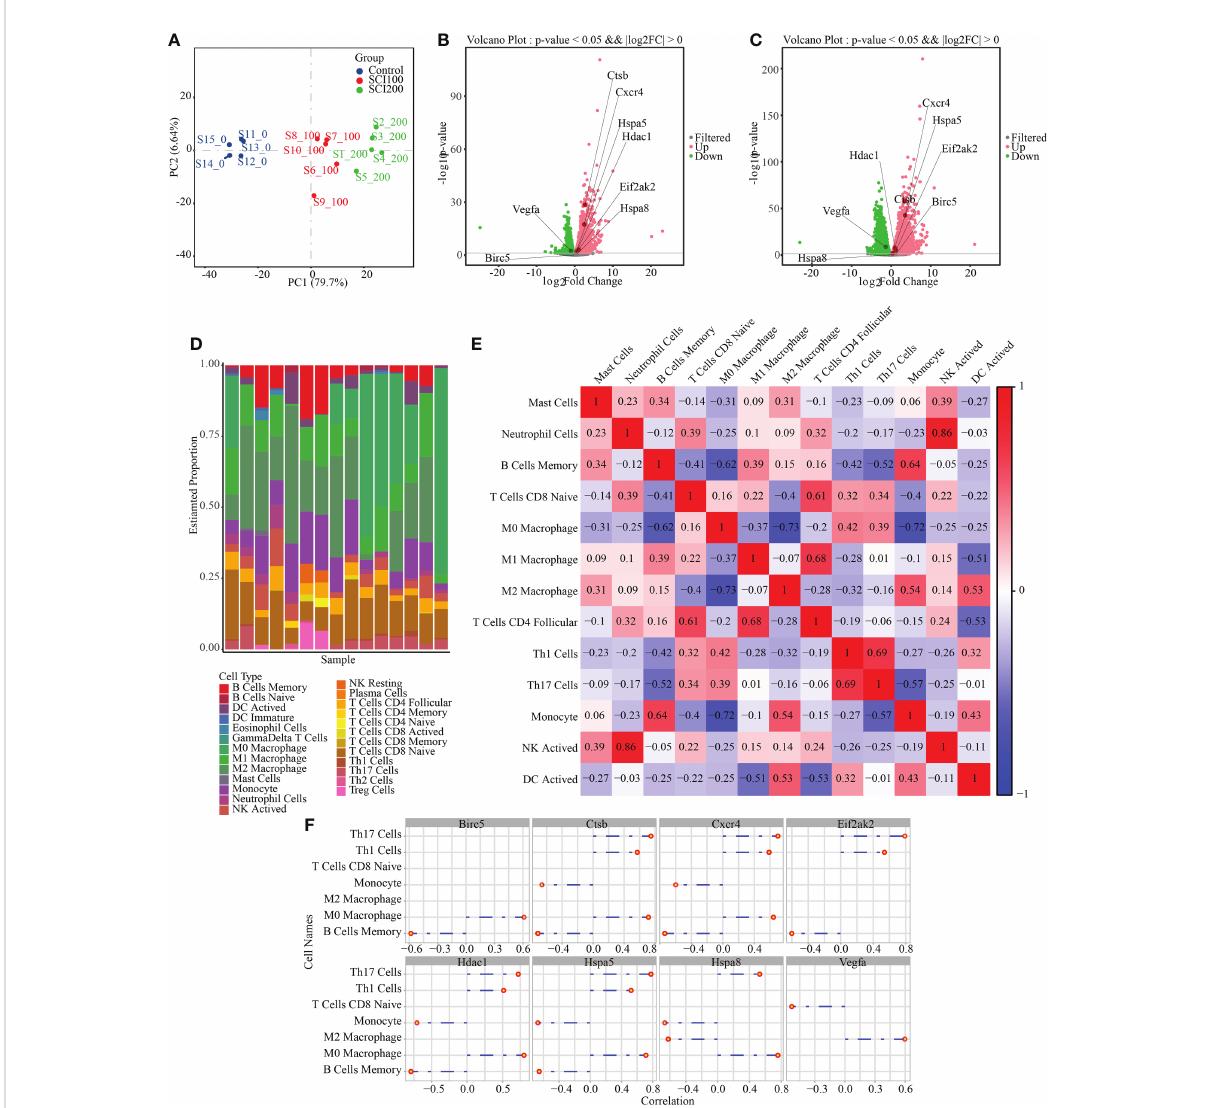
FIGURE 7 Difference analysis and immune cell prediction of RNAseq data. (A) principle component analysis map of the GSE115067 dataset. (B) Volcanic map of differences between groups, in which the differential expression of IRAFs is marked; SCI100-vs- Uninjured. (C) SCI200-vs-Uninjured. (D) Accumulation map of immune cell type score. (E) Correlation heat map of immune cells, where red represents positive correlation, blue represents negative correlation, and white represents no correlation. Darker red or blue color represents a stronger correlation. (F) Visualization of the correlation between IRAF expression and immune